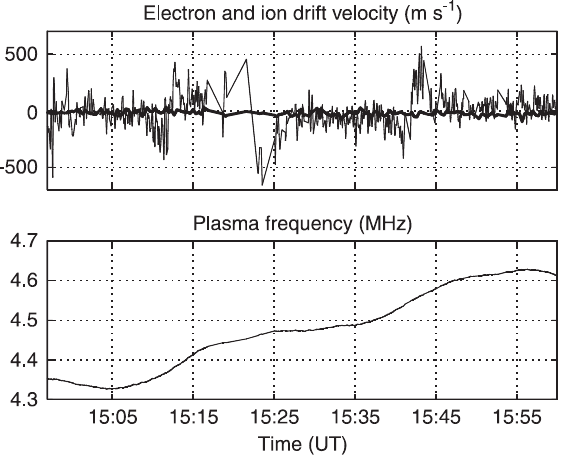
Fig. 10. The upper panel shows the estimated ion drift velocity u i ( thick line ) from the ion line analysis and the electron drift velocity u e ( thin line ) from the analysis method based on Eq. (8) without Fig. 9. Comparison between the measured plasma line intensities and suprathermal population ( a (cid:136) 0) and assuming a Maxwellian ambient the modelled intensities as a function of time. The modelled intensities population with the parameters of Fig. 6. The lower panel shows the are calculated using the P s and Z s functions of Fig. 8 estimated plasma frequency x e = 2 p given by n n